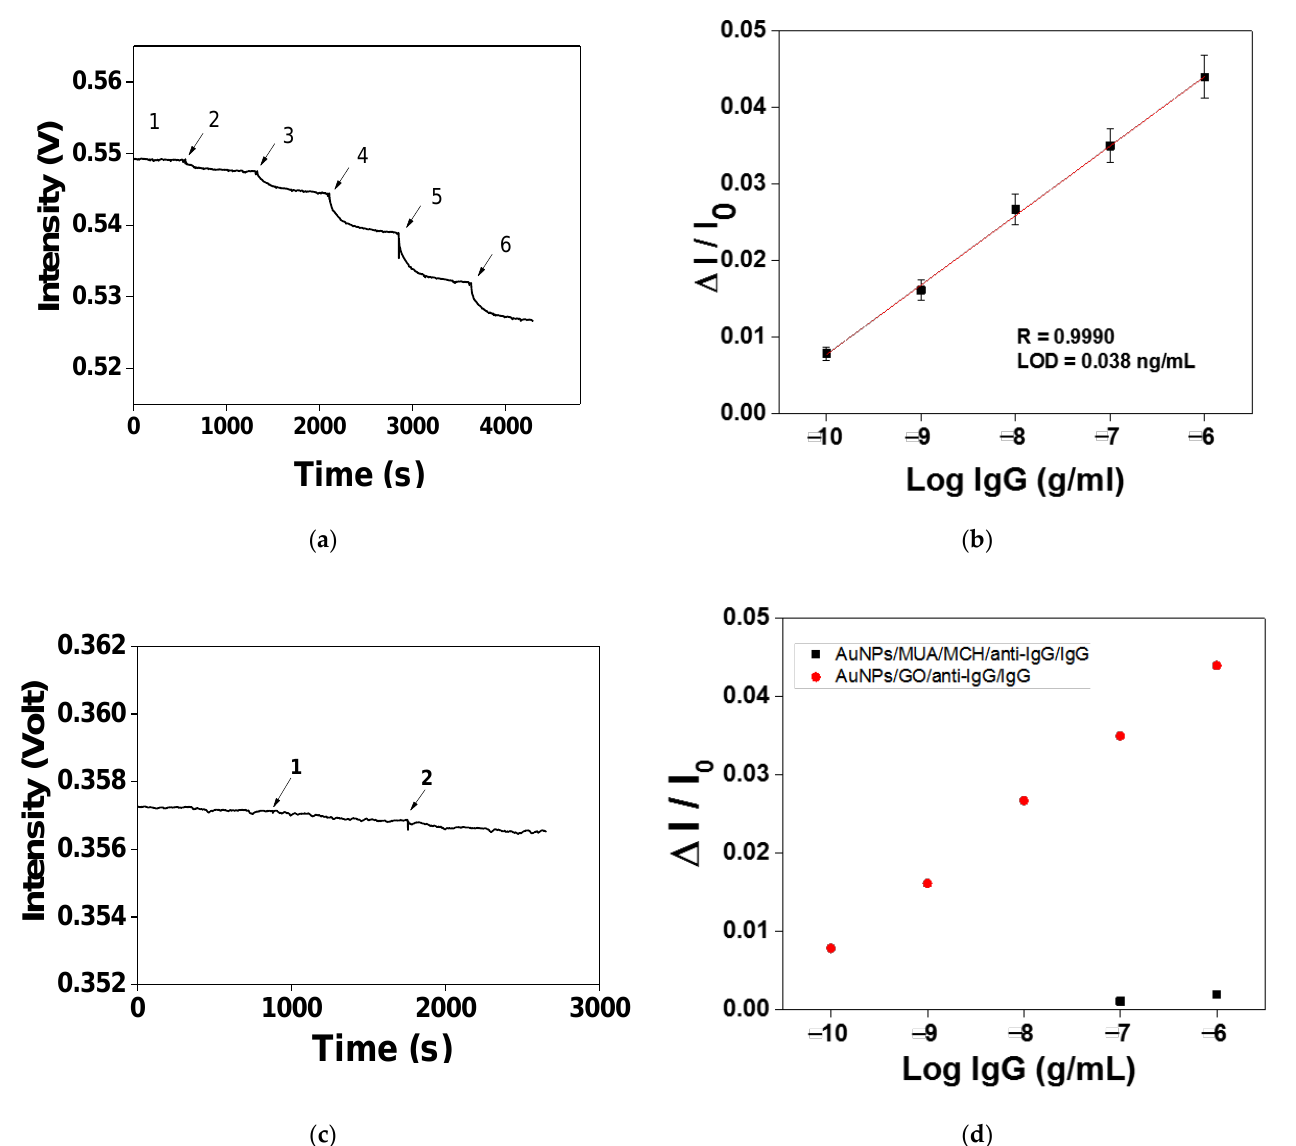
Figure 7. ( a ) Temporal response of the anti-IgG functionalized AuNP – GO probe signal with serial injection of standard solutions with different immunoglobulin G (IgG) concentrations of (1) 1.0 × 10 −10 , (2) 1.0 × 10 −9 , (3) 1.0 × 10 −8 , (4) 1.0 × 10 −7 and (5) 1.0 × 10 −6 g/mL. ( b ) Calibration curve for IgG by anti-IgG-functionalized AuNP – GO probe. ( c ) Temporal responses of the anti-IgG-functionalized AuNPs – MUA/MCH probe with serial injection of standard solutions with different IgG concentrations of (1) 1.0 × 10 −7 and (2) 1.0 × 10 −6 g/mL. ( d ) Comparison between anti-IgG-functionalized AuNP – GO probe and the anti-IgG-functionalized AuNPs – MUA/MCH probe in the FOPPR system.